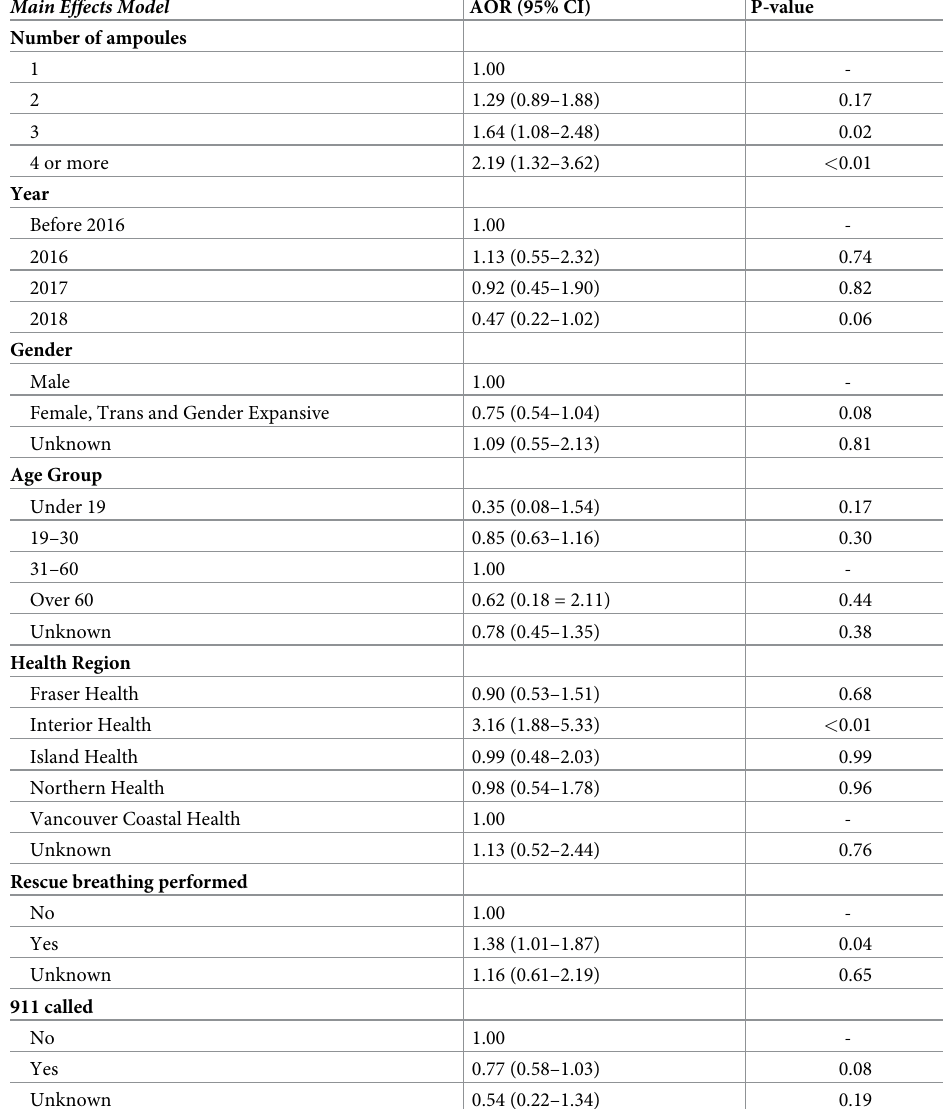
Table 3. Main effects. Adjusted odds ratios and 95% confidence intervals for experiencing moderate or severe with- drawal symptoms. (n =